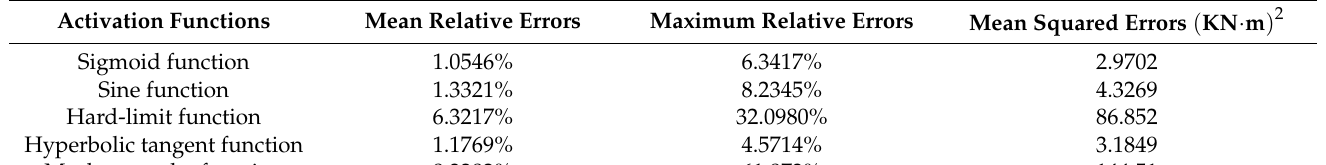
Table 2. Prediction accuracy of wing bending moments under different activation functions.